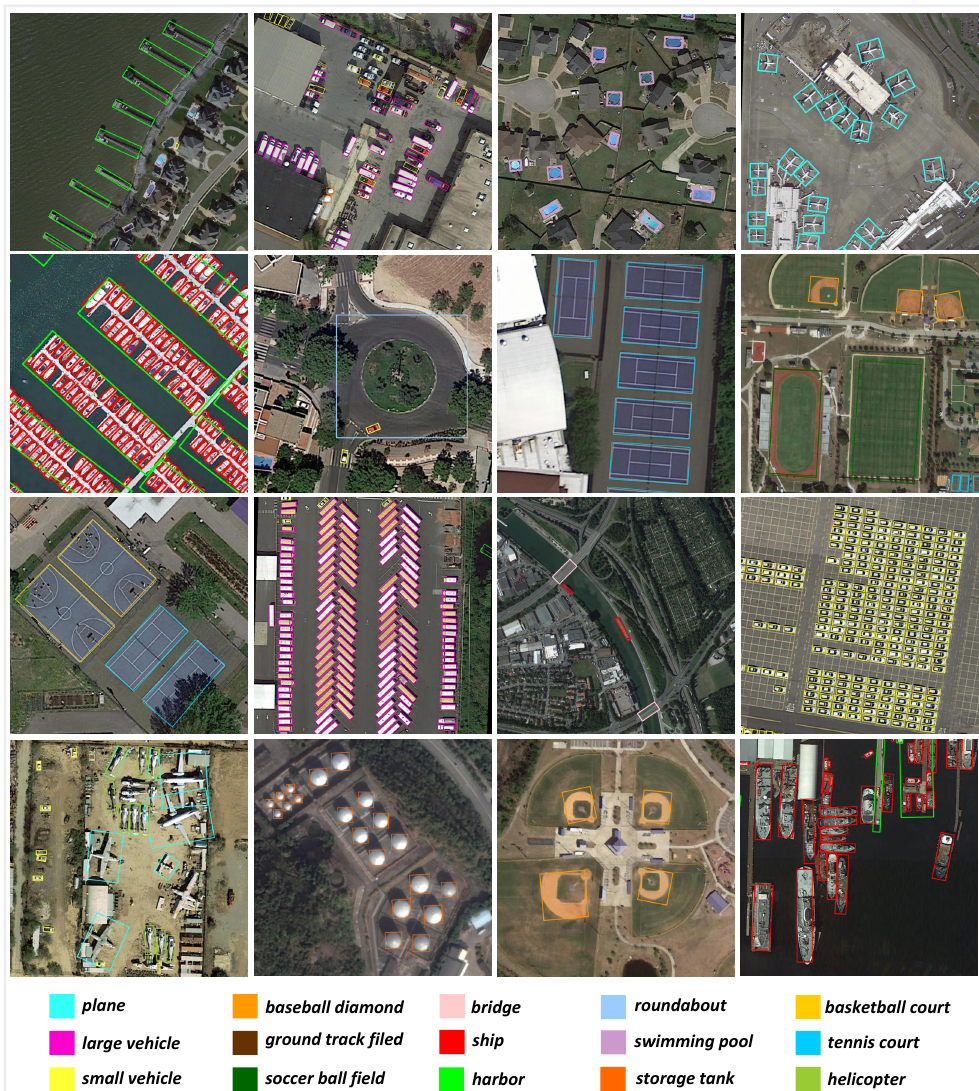
Figure 8. Visualization of detection results on